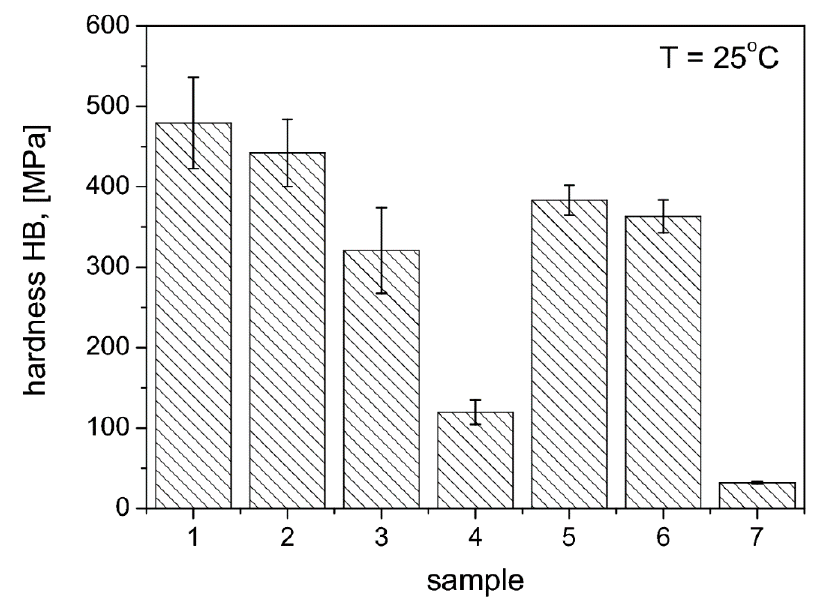
Figure 8. Hardness HB at room temperature (25 °C).